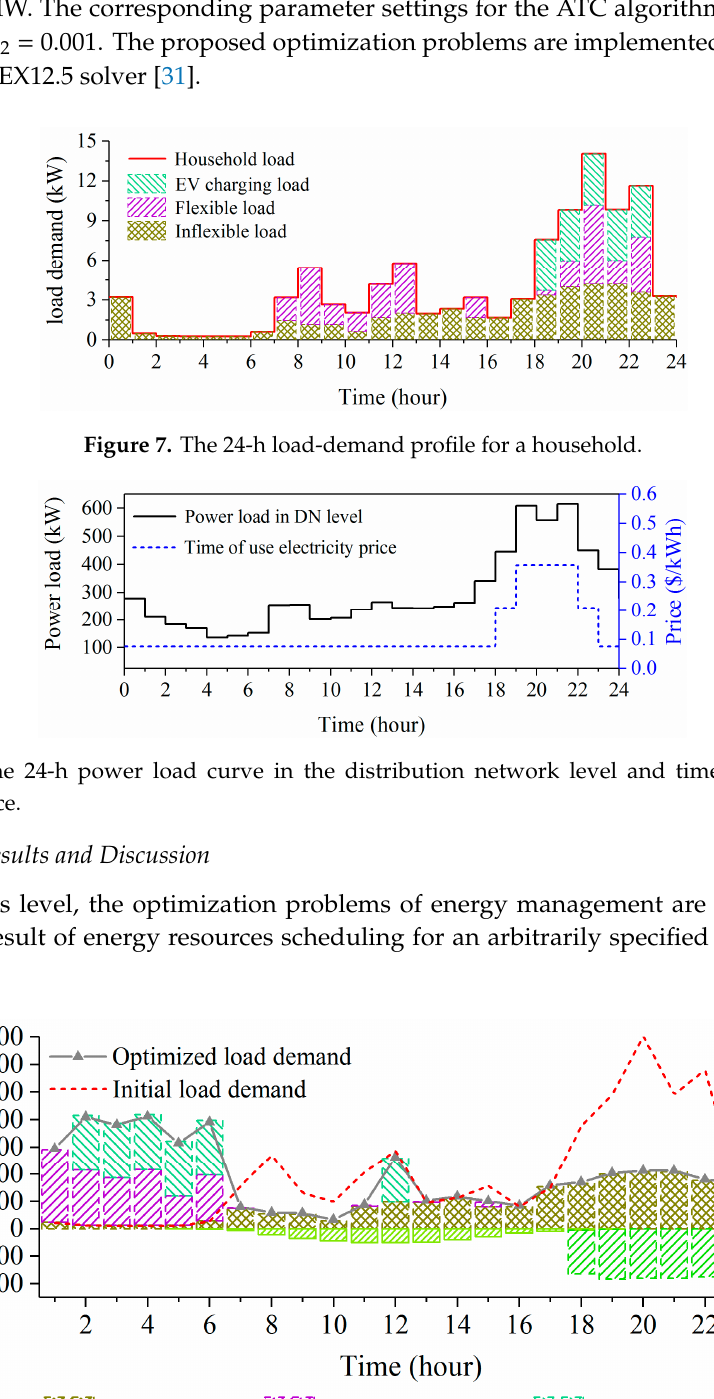
Figure 9. Daily scheduling optimization results for the RMG connected to bus 9.